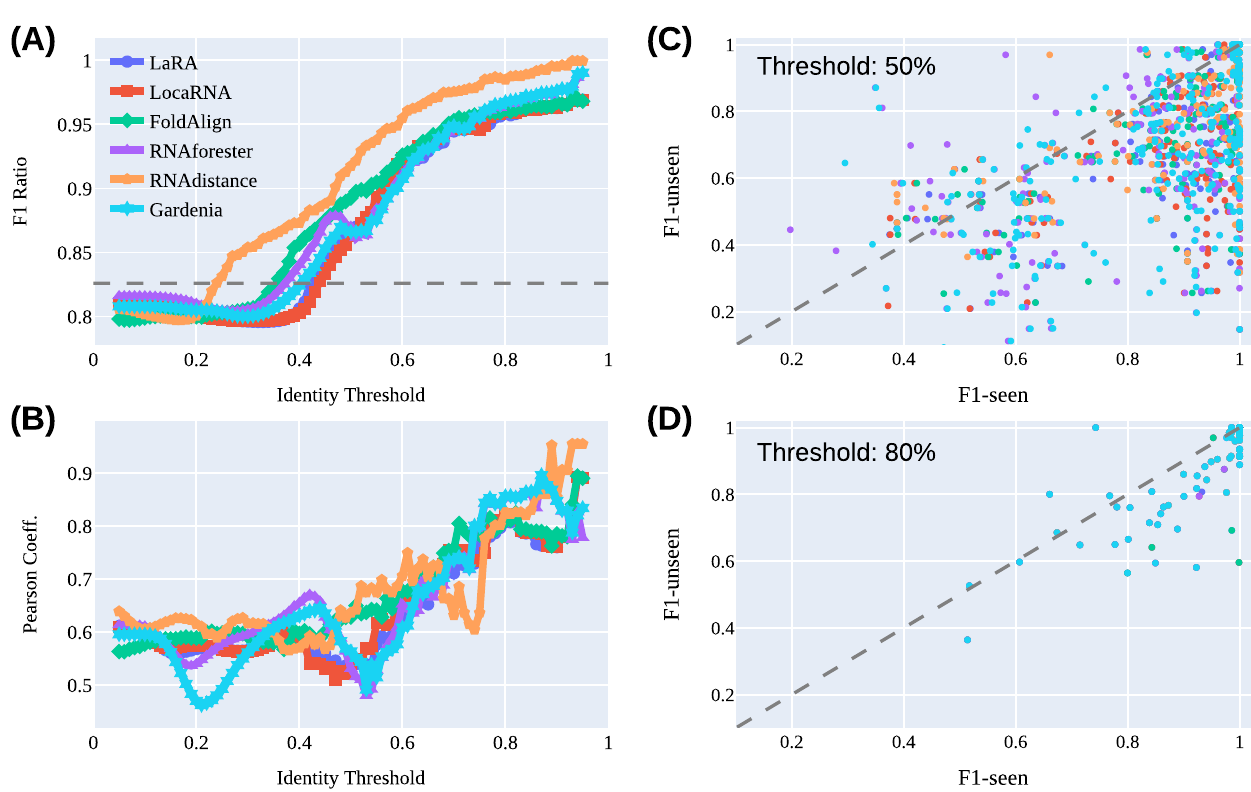
Fig 6. Illustrations of the F1-unseen vs. F1-seen correlations of the SeqFold2D-960K model. Each PSA or PSSA program is shown in the same color in all panels. (A) The F1-unseen over F1-seen ratio as a function of the PSI or PSSI threshold. The horizontal dashed line marks the F1 ratio between the entire unseen and seen datasets. (B) The PCC value as a function of the identity threshold. (C) The distributions of the F1-unseen and F1-seen scores at the nominal PSI or PSSI threshold of 50%. (D) The distributions of the F1-unseen and F1-seen scores at the identity threshold of 80%. It is common to find no seen sequences above high thresholds for an unseen sequence, leading to many null F1-seen values that are absent in (D).